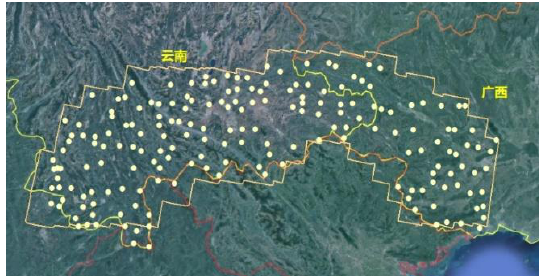
Fig 4: Distribution of GCPs in the Yunnan and Guangxi regions Table 4: Adjustment accuracy comparison of the east, west and whole teat areas without